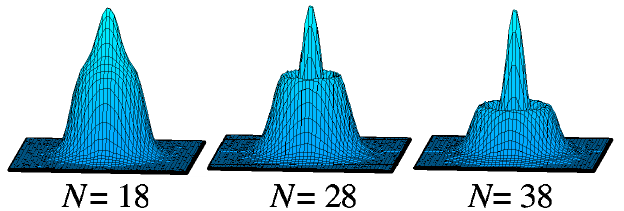
FIG. 12. (Color) Optical field amplitude j a (cid:3) x; y (cid:5)j at the output mirror for various number of undulator periods N . Increasing the number of periods, in addition to reducing the extraction, also distorts the optical mode away from the